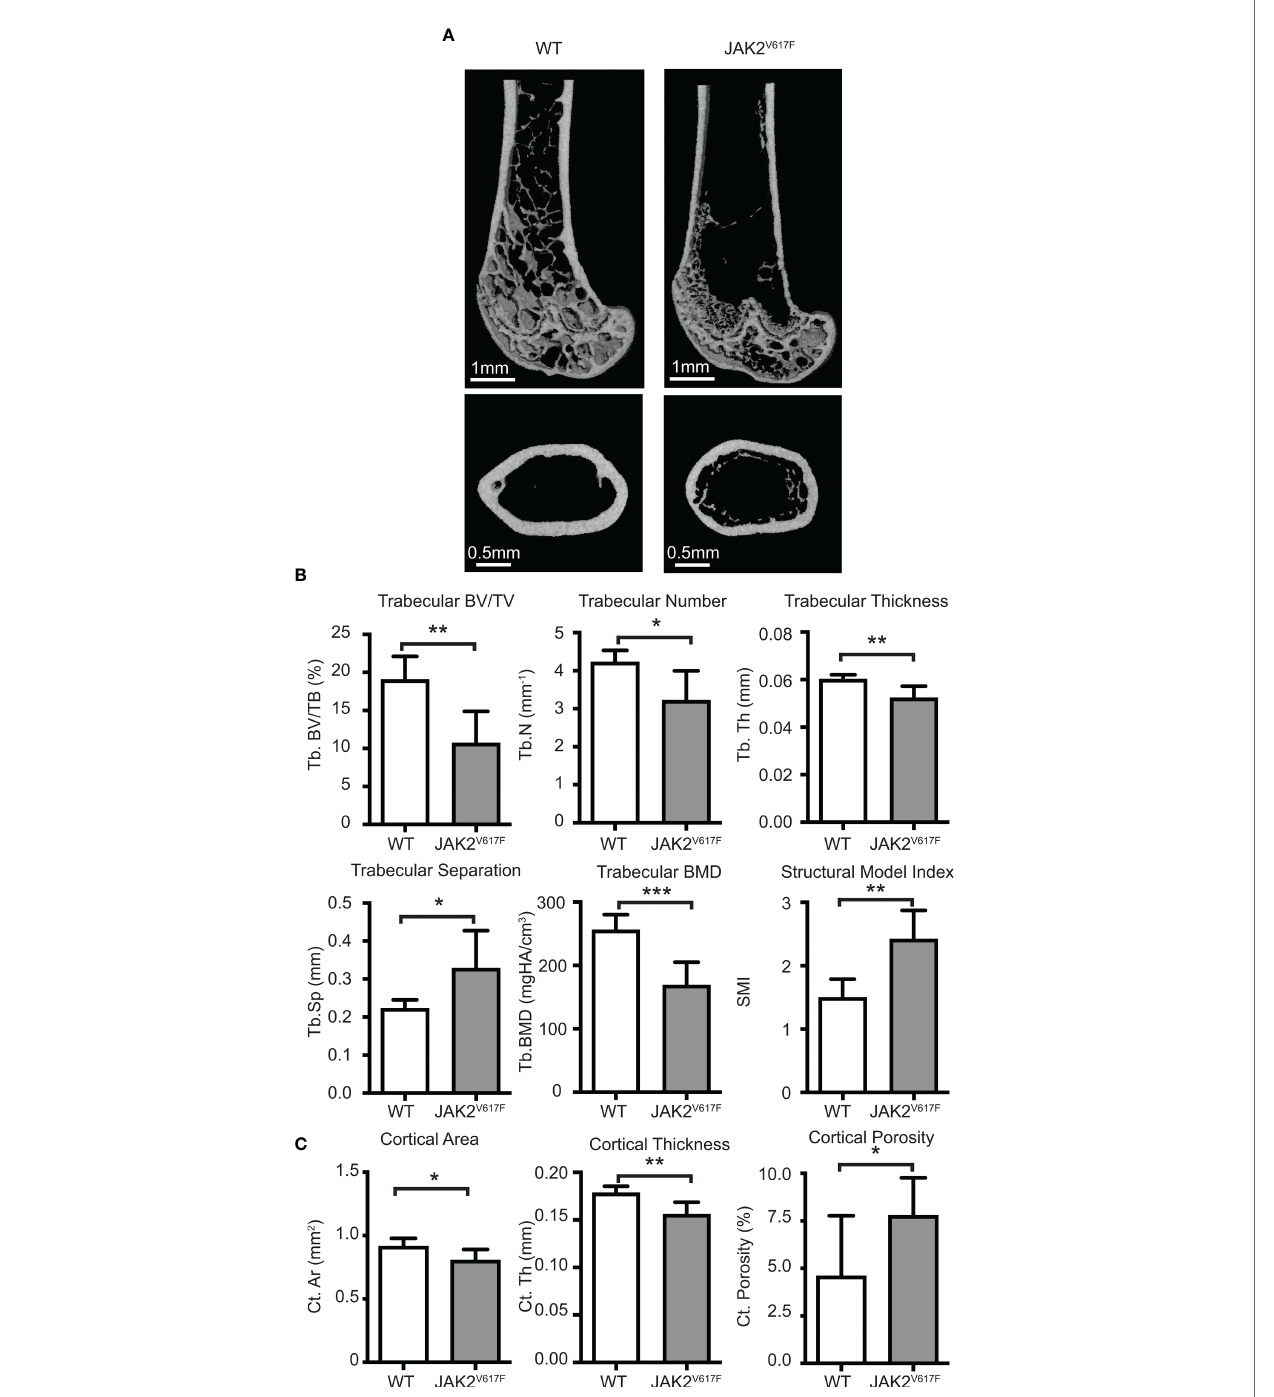
FIGURE 1 | Micro-CT analyses. Femurs of JAK2 V617F mice and matching controls were subjected to micro-CT analysis. (A) Representative micro-CT images. The upper panel is showing the distal femoral metaphysis and the lower panel is showing the femoral mid-diaphysis. (B) Quantitative micro-CT analysis of trabecular structure. Measurements include trabecular bone volume fraction (Tb.BV/TV, %), trabecular bone mineral density (Tb. BMD, mgHA/cm 3 ), trabecular thickness (Tb.Th, mm), trabecular number (Tb.N, mm -1 ), trabecular separation (Tb.Sp,mm), and structural model index (SMI). (C) Quantitative micro-CT analysis of cortical structure. Measurements include cortical bone area (Ct.Ar, mm 2 ), cortical thickness (Ct.Th, mm), and cortical porosity (Ct. Porosity, %). The rest of the cortical measurements can be found in Supplementary Figure 2 . Measurements are presented as mean ± SD. Seven JAK2 V617F and six WT 30 weeks old male mice were analyzed, at an age where potential effect on bone might be more fully manifested. *Denotes p<0.05; **Denotes p<0.01; ***Denotes